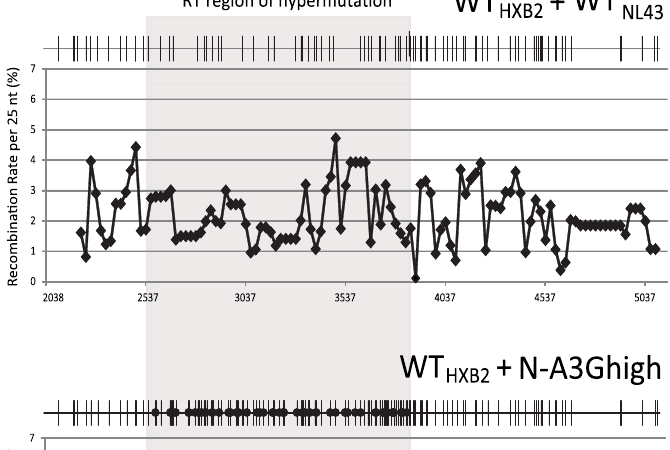
Fig 2. Single-cycle recombination rates across the target pol gene. The recombination rate per 25-nt region is plotted for each pair of parent viruses. The RT region where hypermutation was introduced is shaded in gray. Nucleotide numbering corresponds to HXB2 (GenBank Accession number K03455). A total